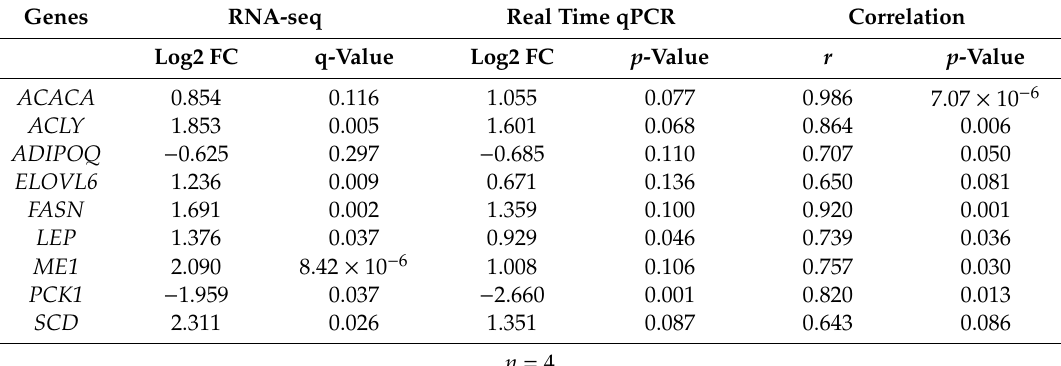
Table 1. Gene expression comparison through RNA-seq and Real Time qPCR of the selected genes. Genes RNA-seq Real Time qPCR Correlation Log2 FC q-Value Log2 FC p -Value r p